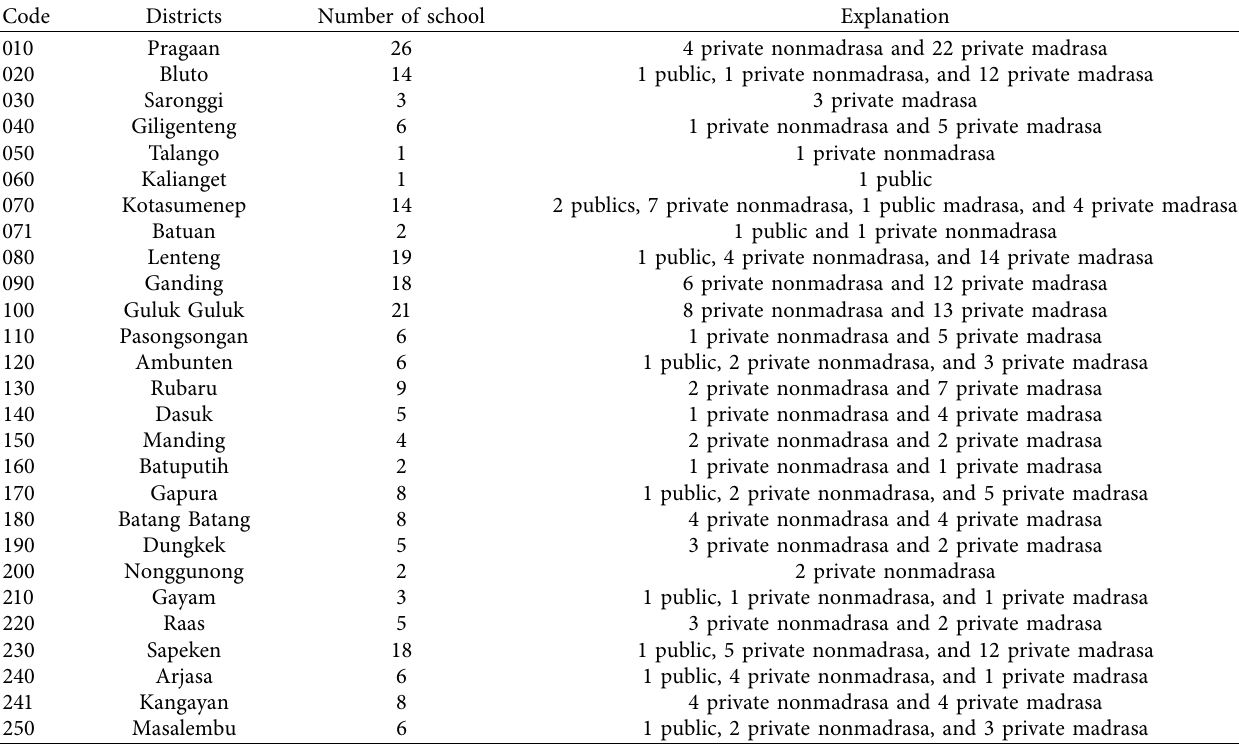
Table 2: Number and kind of school in each district.